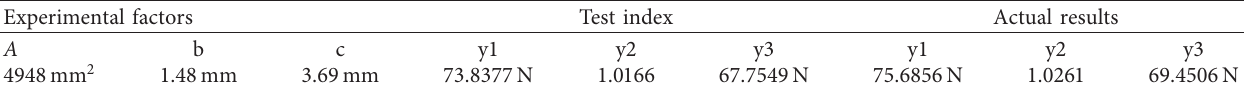
Figure 11: Effect of experimental parameters on the pull. (a) Effect of area and displacement. (b) Effect of area and thickness. (c) Effect of thickness and displacement. Table 5: Optimal performance and corresponding